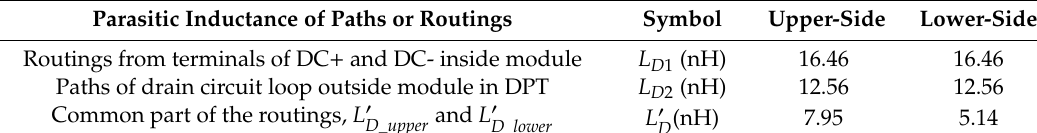
Table 4. Summary of the parasitic element of modules and DPT.